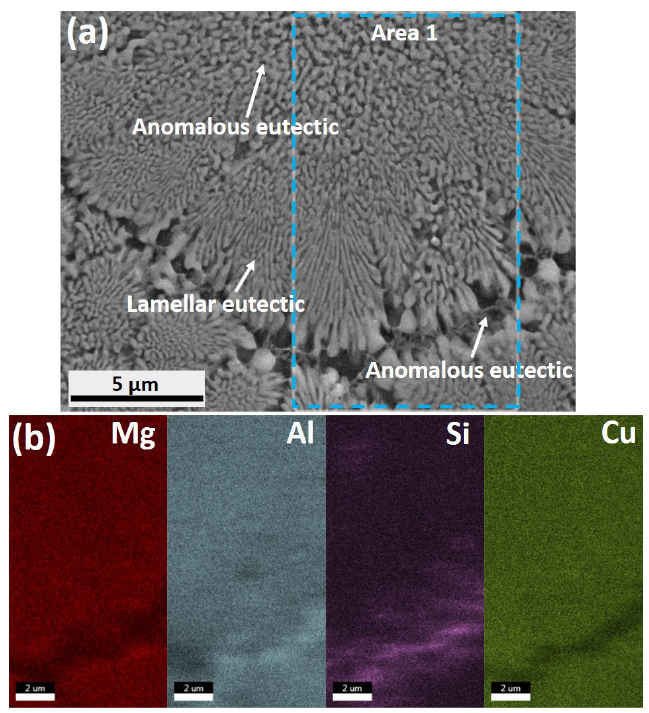
Figure 4. ( a ) SEM secondary electron image taken from a transverse section at half-length of the sample under high magnification ( b , c ) SEM-EDX point analyses of Spot 1 and Spot 2 obtained from ( a ).